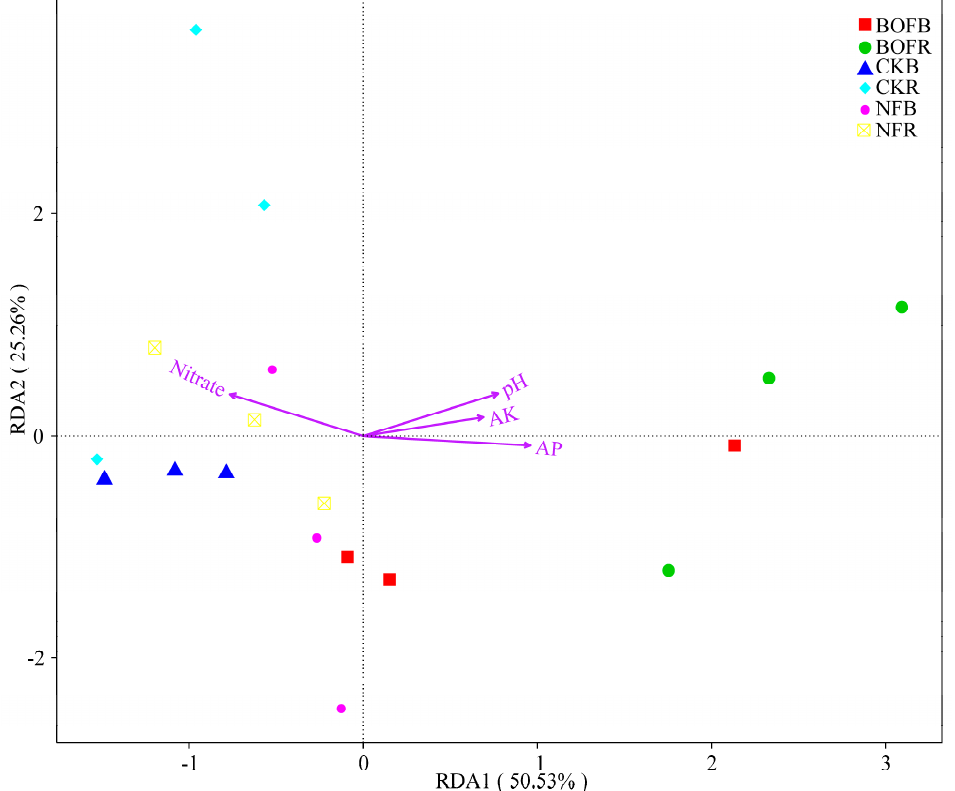
Figure 3. T-test analysis of bacterial community structure at the ( a ) phylum level and ( b ) order level between NFR and BOFR. NFR, rhizosphere of nitrogen fertilizer; BOFR, rhizosphere of bioorganic fertilizer.